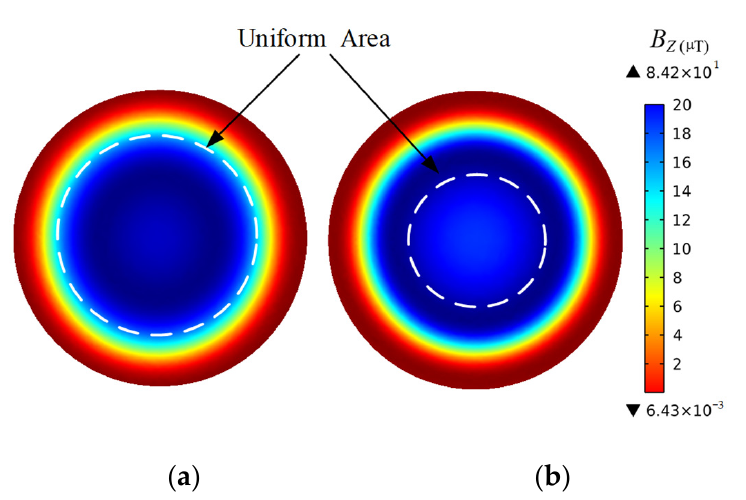
Figure 9. The magnetic induction intensity distribution on the S -plane: ( a ) with PI coil; ( b ) without PI coil. Table 2. The parameters of magnetic coupling mechanism.